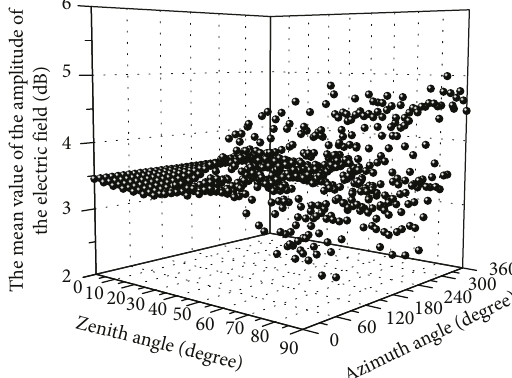
Figure 12: The variance of the amplitude of the electric fi eld for di ff erent inclination angles in the LOS corridor (scatter diagram).